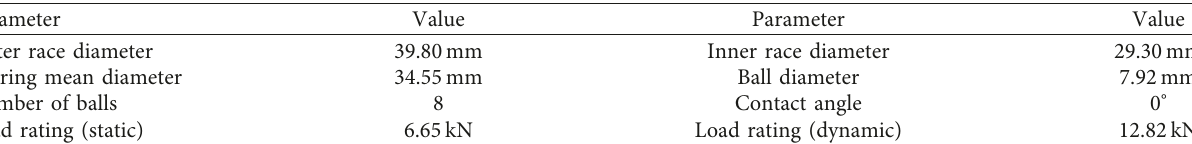
Figure 16: XJTU-SY fault diagnosis laboratory. Table 5: Parameters of testing bearing.